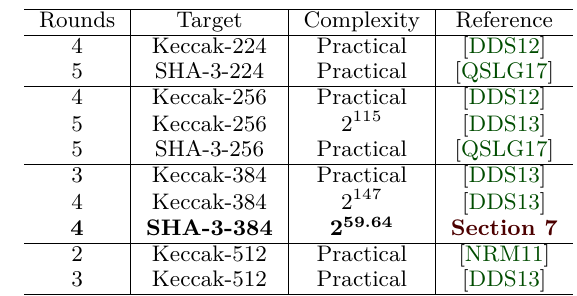
Table 1: Summary of existing collision attacks on